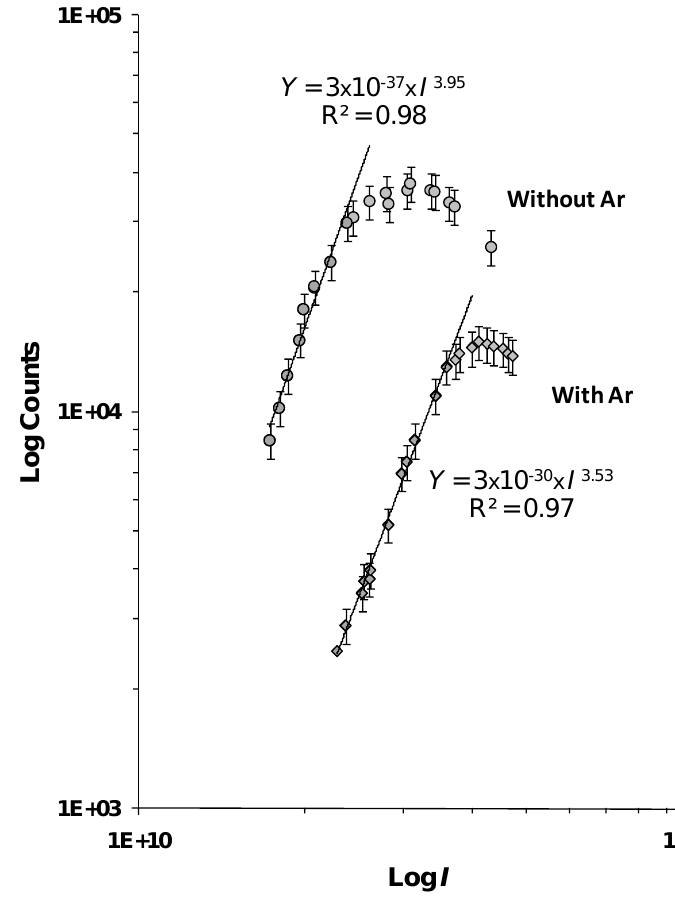
Figure 4. Log-Log plots of the total ion currents of tetracene with or without carrier